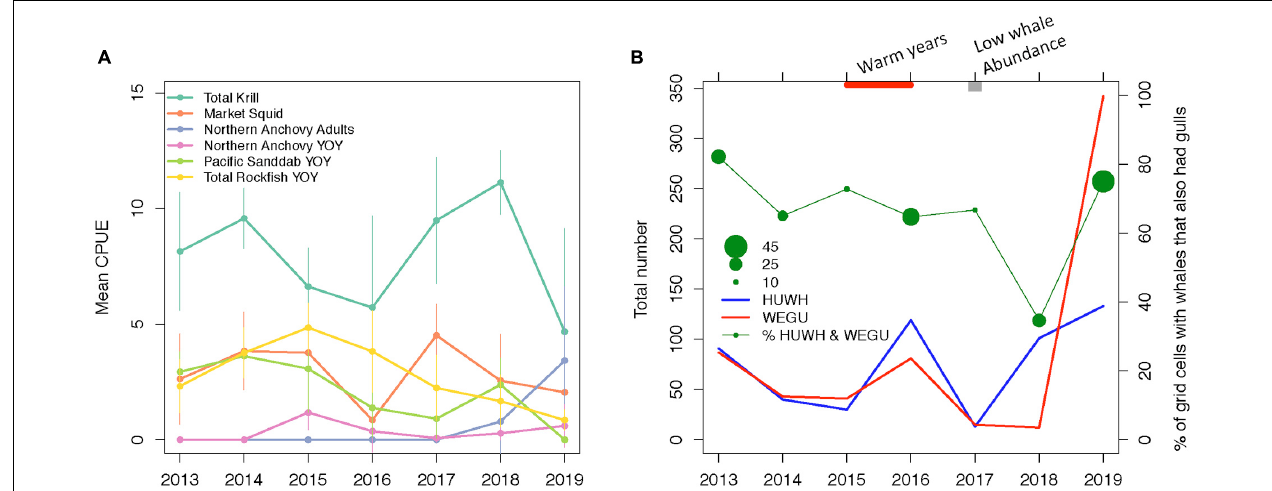
FIGURE 5 | Prey indices and predator overlap from the ecosystem survey. (A) Mean and standard deviation in Catch-Per-Unit-Effort [ln(CPUE + 1)] of prey species within the 5 or 6 trawl stations surrounding the Farallon Islands (see Supplementary Figure 3 ). For taxa with multiple species, the “total” abundance of all species was used. (B) The number of humpback whales (HUWH, blue line) within 5 km × 5 km grid cells within the gull foraging domain (blue box in Figure 1 ) and the number of western gulls (WEGU, red line) in grid cells where humpback whales were observed from 2013 to 2019. The percentage of grid cells with whales that also had gulls (green line) with the size of the circle indicating the number of grid cells where at least 1 whale was present. During 2015 and 2016, there were marine heatwave impacts on our study area, and in 2017, there were regionally low humpback whale